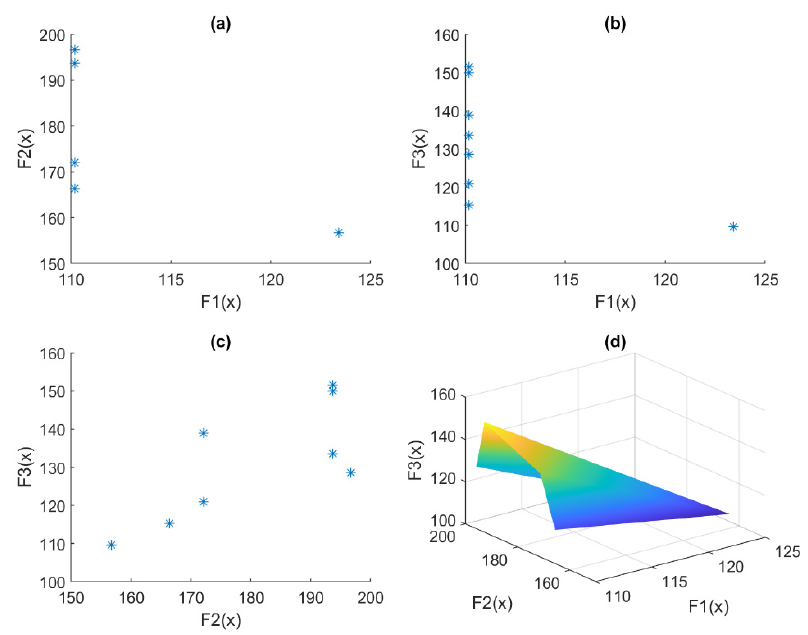
Figure 5. Results of NBI method: ( a ) F1 vs. F2; ( b ) F1 vs. F3; ( c) F2 vs. F3; ( d ) 3D plot.